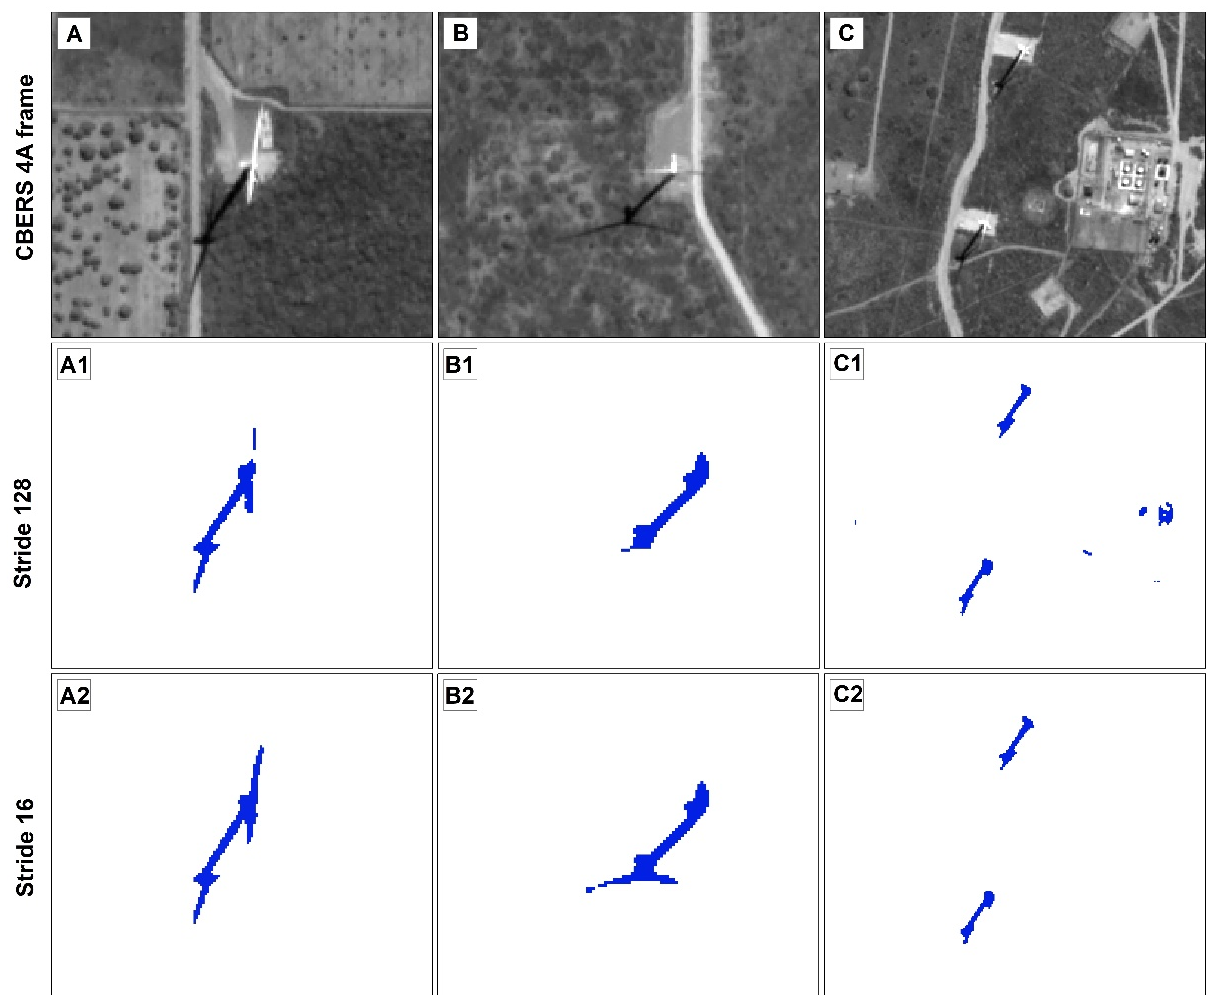
Figure 6. Differences in the results from the sliding windows approach using different stride values, in which A – C are three CBERS-4A images, A1 – C1 are the predictions using a stride of 128, and A2 – C2 are the predictions using a stride of 16.